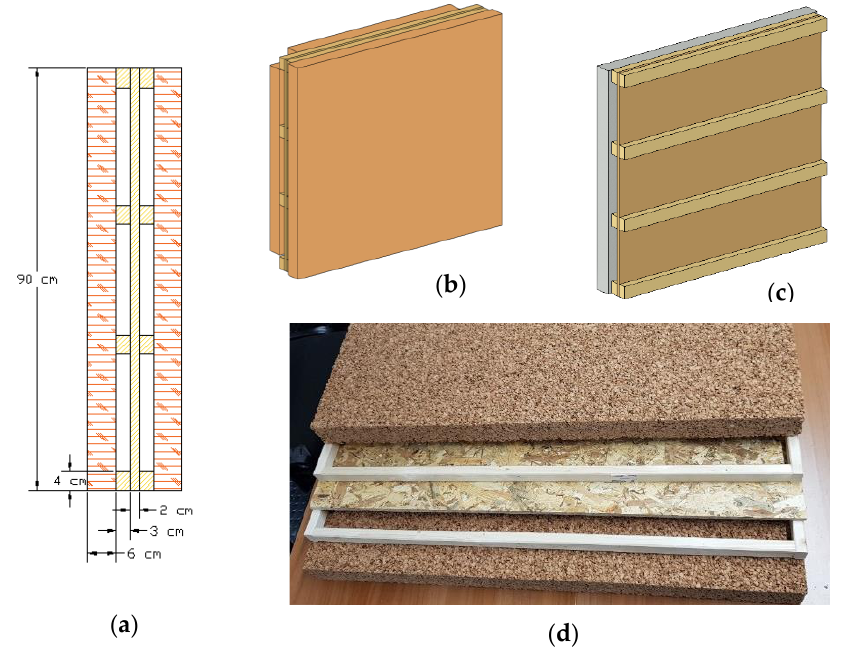
Figure 1. The stratigraphy of the SuberWall panel ( a ). Front view of the module ( b ). Front view of the module without the covering cork layer ( c ). Disassembled materials ( d ). Table 2. Thermo-physical and optical properties of the materials used for the SuberWall panel [34].